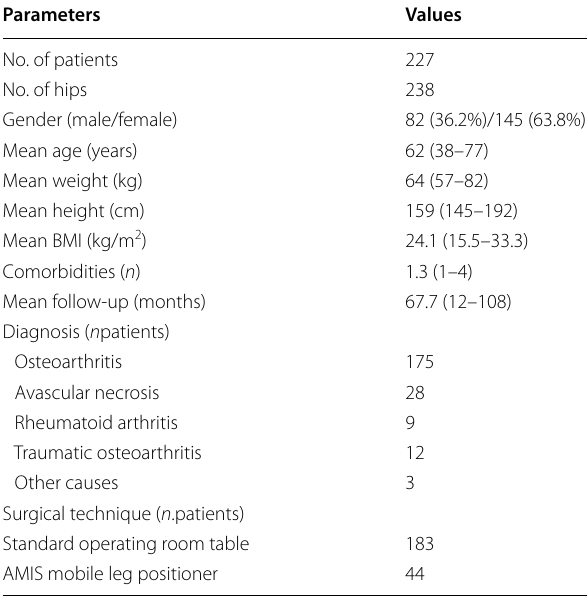
Table 1 Demographic data of patients Table 2 Major and minor